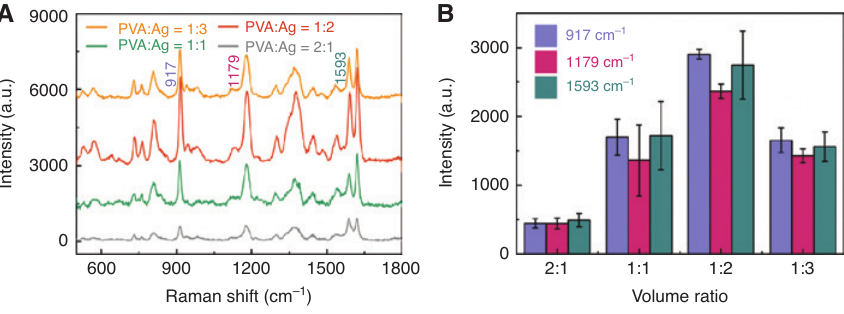
Figure 3: Influence of the PVA/Ag volume ratio for the SERS activity. (A) Raman spectra of CV molecules (10 −5 m) detected on PVA@Ag nanofibers substrate with different PVA/Ag volume ratio. (B) The intensity of the CV at 917 cm −1 , 1179 cm −1 , and 1593 cm −1 peak changes as a function of volume ratio on PVA@Ag nanofibers substrate.